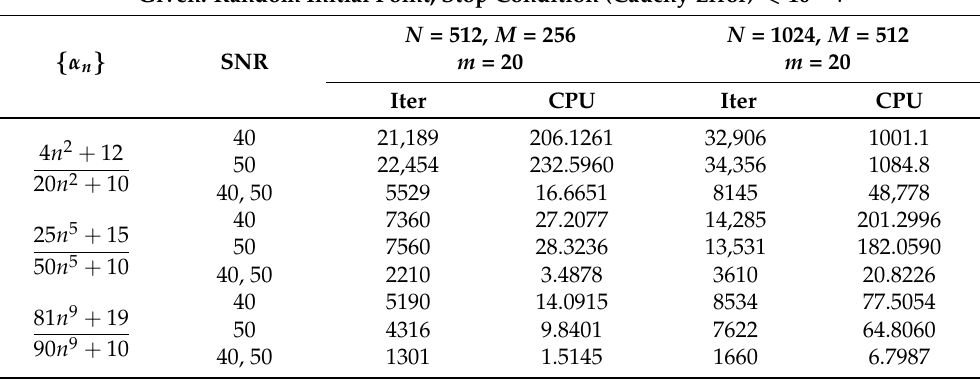
Table 3. The convergence of Algorithm 6 with each { α n }